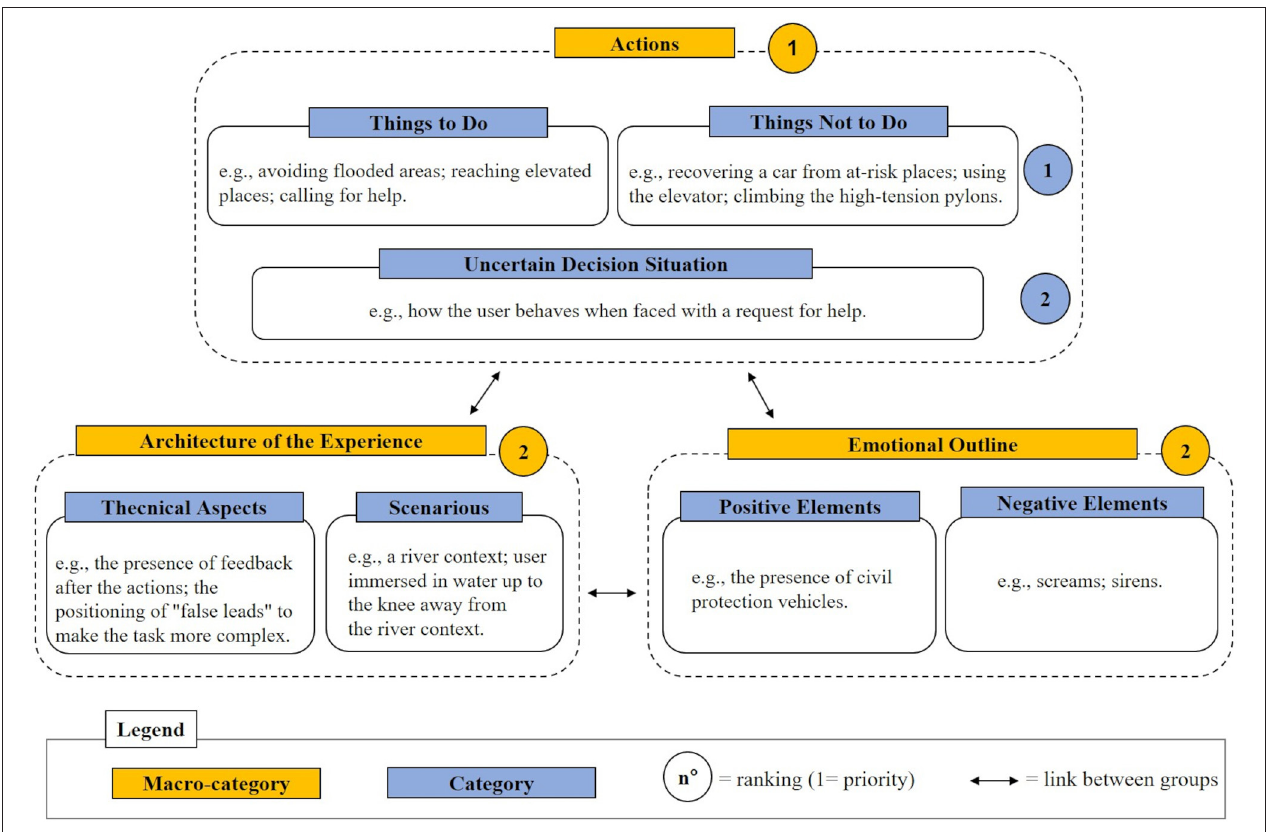
FIGURE 3 | Schematic representation of the results of the second affinity diagram